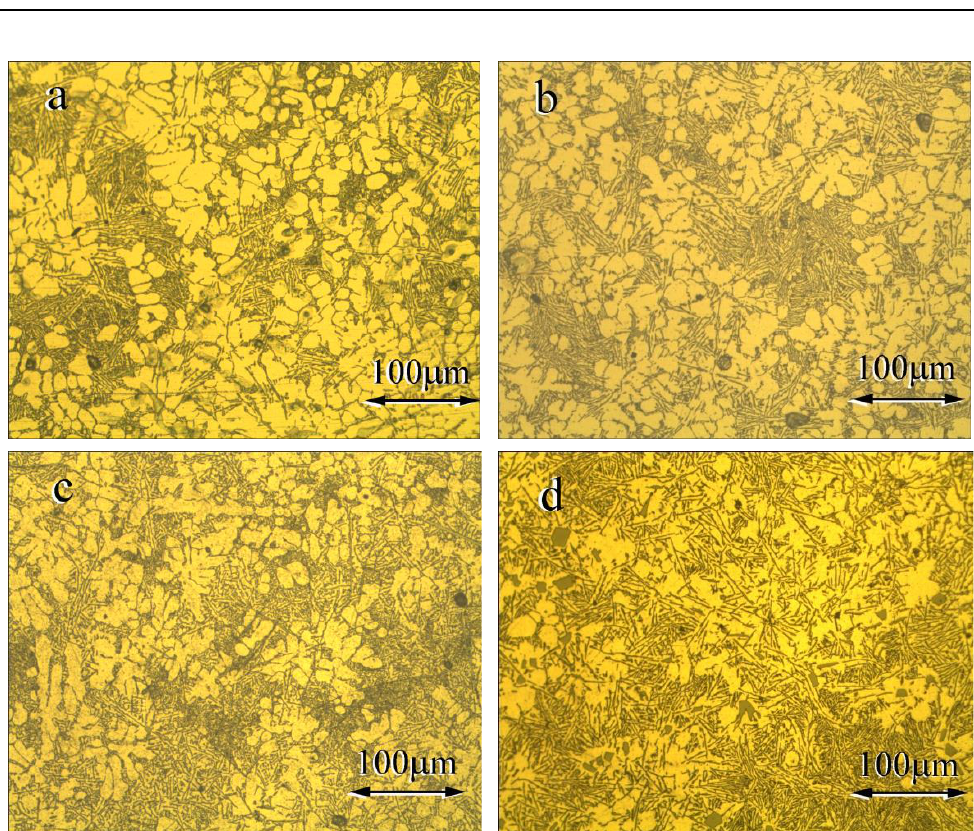
Figure 1. Microstructures of the as-cast Al-Si alloys containing the following Si contents: ( a ) 9.8% Si; ( b ) 10.8% Si; ( c ) 11.8%Si; and ( d ) 12.8% Si.